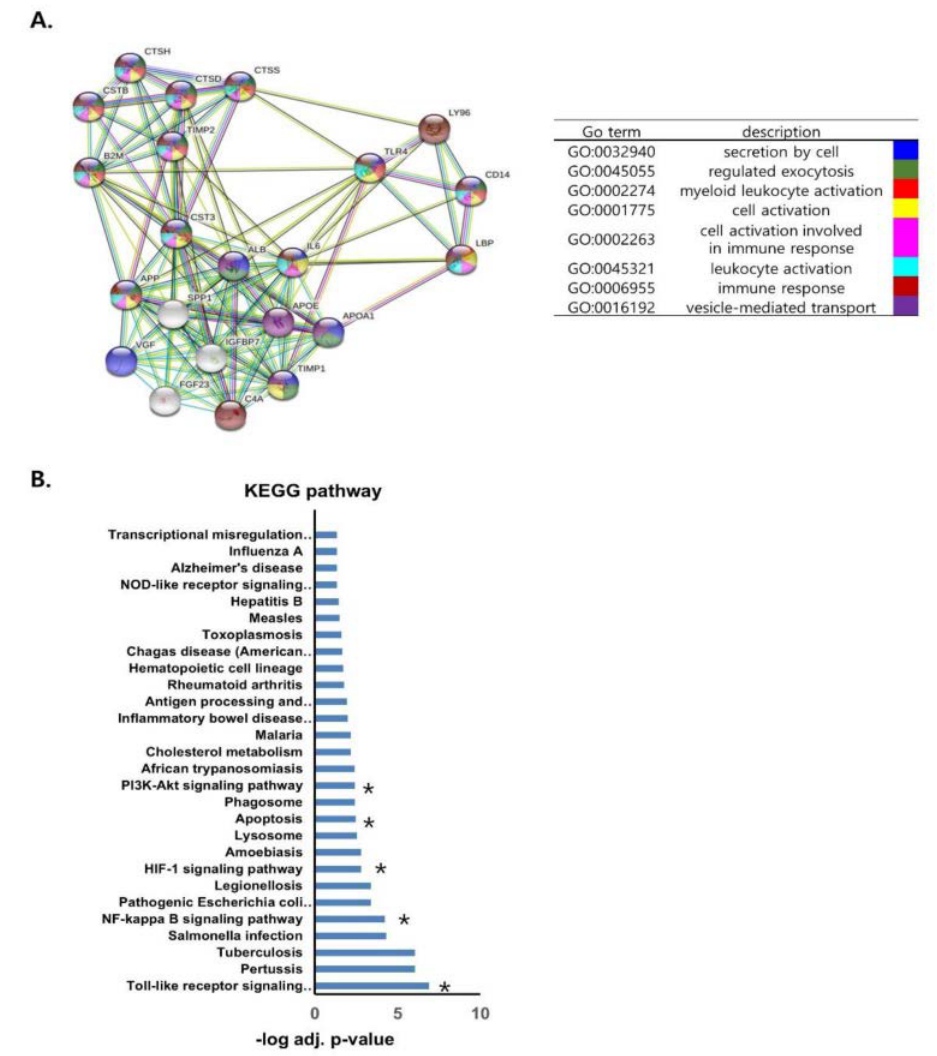
Figure 7. Protein − protein interaction network and co − expression analysis of LBP and CST3. ( A ) Protein − protein interaction network of the interactors using the STRING online database. The confidence score was set to 0.4 and the interactors were set to no more than 20 with first shell of interaction for human. Red, green, blue, purple, yellow, light blue, and black lines indicate the presence of fusion evidence, neighborhood evidence, co − occurrence evidence, experimental evi- dence, text mining evidence, database evidence, and co-expression evidence, respectively. ( B ) Kyoto Encyclopedia of Genes and Genomes (KEGG) pathway analysis of differentially expressed genes. A total of 28 pathways were significantly enriched. Asterisk indicates that the pathways are associated with allograft rejection according to previous studies. * pathways which are known to be associated with